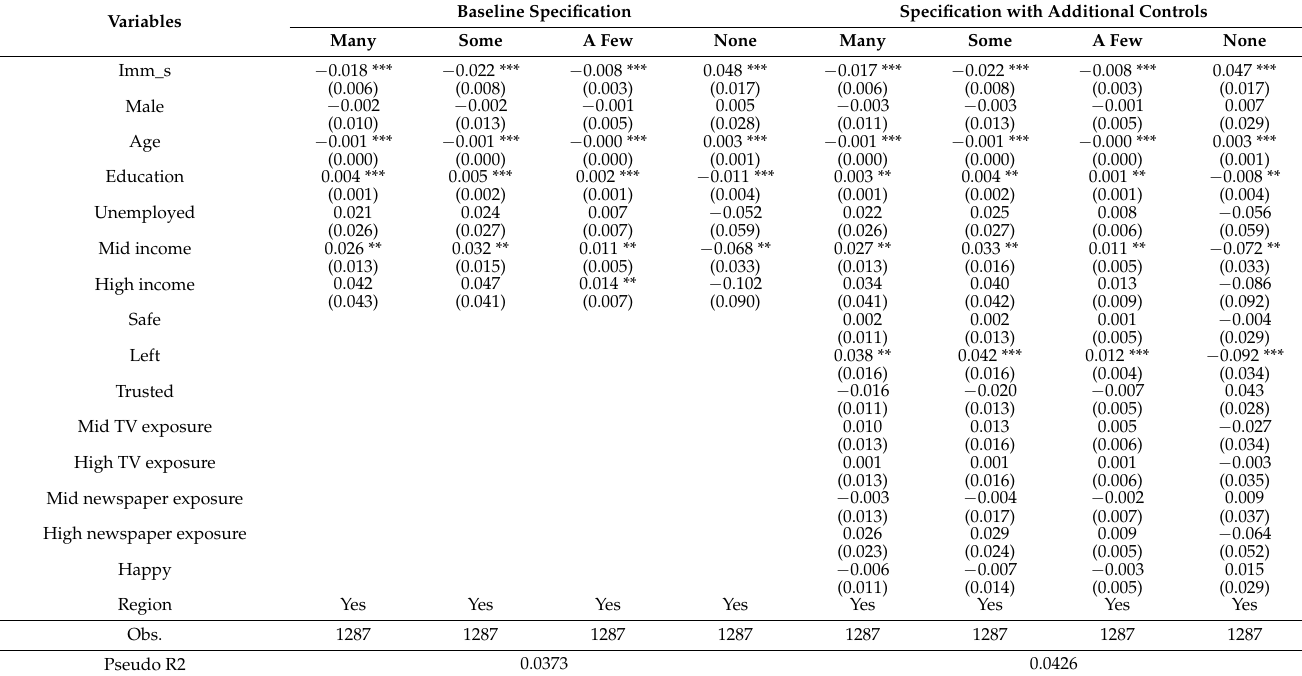
Table 4. Should Turkey allow people of a different race or ethnic group from most Turkish